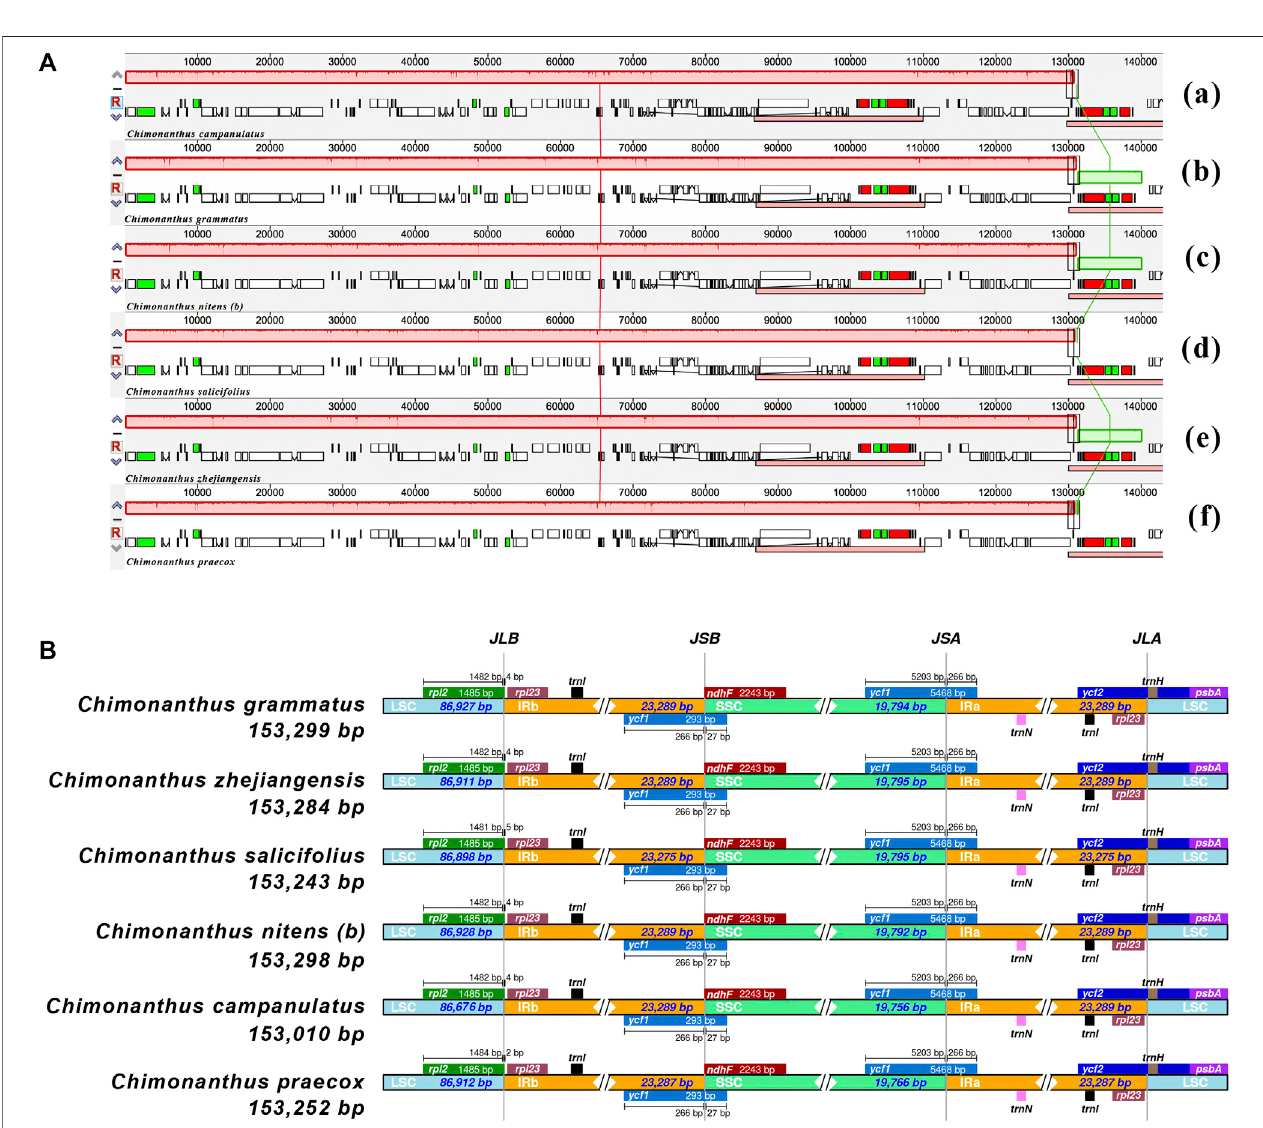
FIGURE 2 | Comparativeanalysisofgeneorderandjunctionsitesin Chimonanthus chloroplastgenomes. (A) Mauvealignmentofsix Chimonanthus chloroplastgenomes. Within each of the alignments, local collinear blocks are represented by blocks of the same color connected by lines. (a) C. campanulatus , (b) C. grammatus , (c) C. nitens (b) , (d) C. salicifolius , (e) C. zhejiangensis , and (f) C. praecox . (B) The IRscope based analyses provide insight into similarities and variations at junction sites of cp genomes. For each species, genes present on the top of their corresponding track transcribed in positive strand from right to left direction whereas genes present below their respective track transcribe on negative strand from left to right direction. JLA, JLB, JSA, and JSB denote corresponding junctions between the LSC, SSC, and IR regions. The genes extending fromoneregiontoanotherregionofchloroplastgenomesareshownwiththeTbaraboveorbelowthesolidlines.ThesizeofTbarscorrespondstothelengthofthegenesorgene fragments present in the different regions. The plotted genes and distances in the vicinity of the junction sites are the scaled projection of the genome.